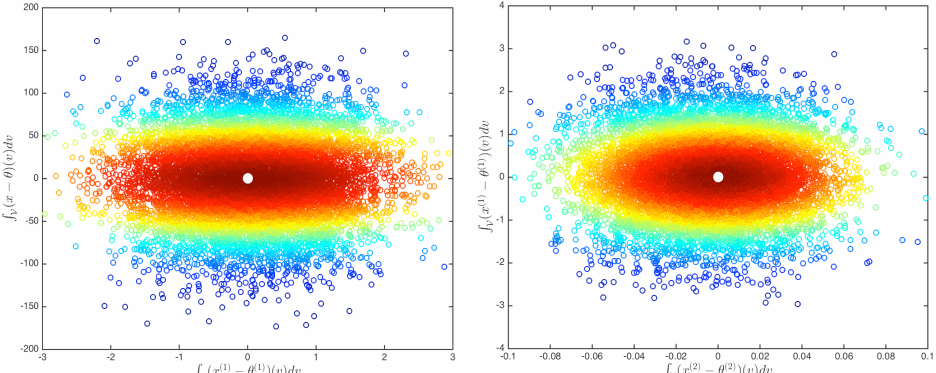
Figure 3. Symmetries induced in the domain of the integration of a Gaussian process with correlation length 1 minus its center of symmetry versus the integral of its first derivative ( left ) and of the first derivative versus the second ( right ). The color represents the metric depth in Sobolev-(2,2) distance ( left ) and in the Sobolev-(2,2) distance minus the L 2 distance ( right ), with the center depicted by a white